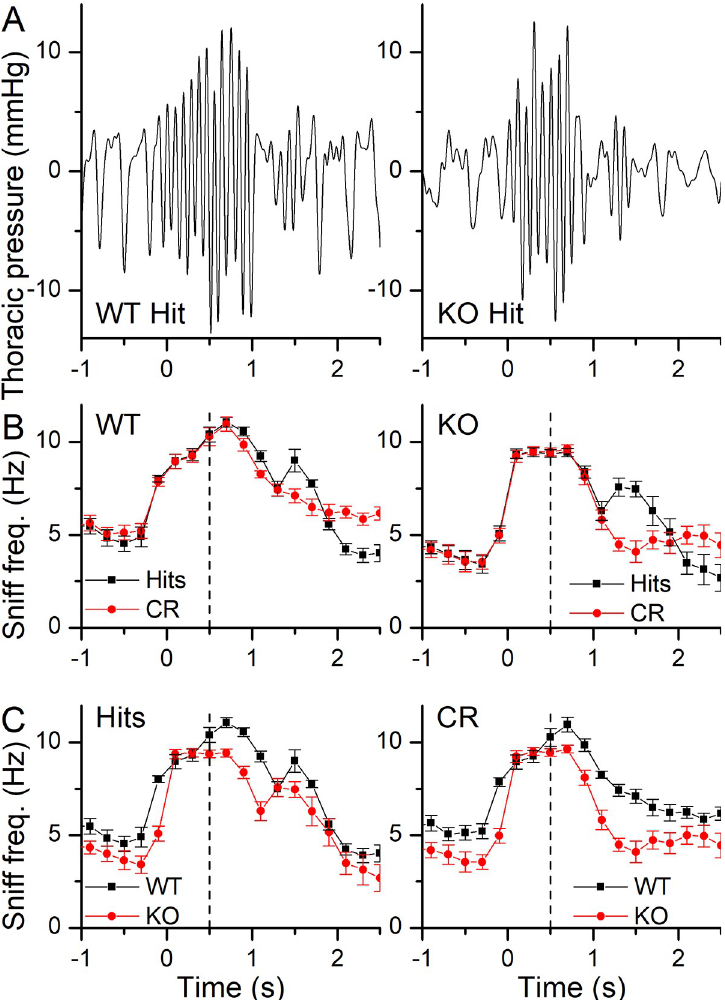
Fig 8. Recordings of thoracic pressure changes during odorant sampling at different background odorant concentrations. A Thoracic pressure changes during a Hit trial of a WT (left) or a NCKX4 KO (right) mouse when tested with 10 − 4 propanol delivered in the odor port and with the background odor of the control mineral oil. Time 0 marks the nose poke into the odor port and the start of the trial. Odorant delivery began at 0.5 s. B The sniff frequency of Hits and CRs of a WT (left) and a KO (right) mouse when tested with 10 − 4 propanol vs mineral oil delivered in the odor port in the presence of mineral oil as the control background odorant. C Comparison of Hits (left) and CRs (right) between WT and KO mice. Sniff frequencies were binned in 0.2 s bins according to their behavioral outcome and averaged (mean ± SEM) across trials of one block of 20 trials. Vertical dashed line indicates odorant